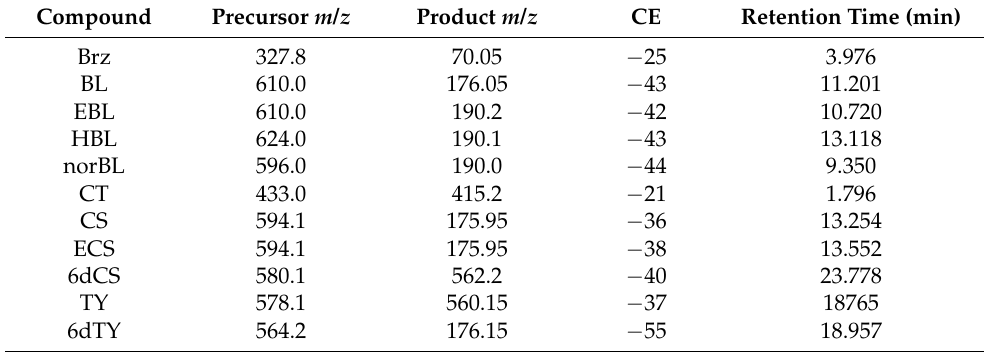
Table 3. Chromatographic properties of Brz and BRs in positive ionization scan mode of